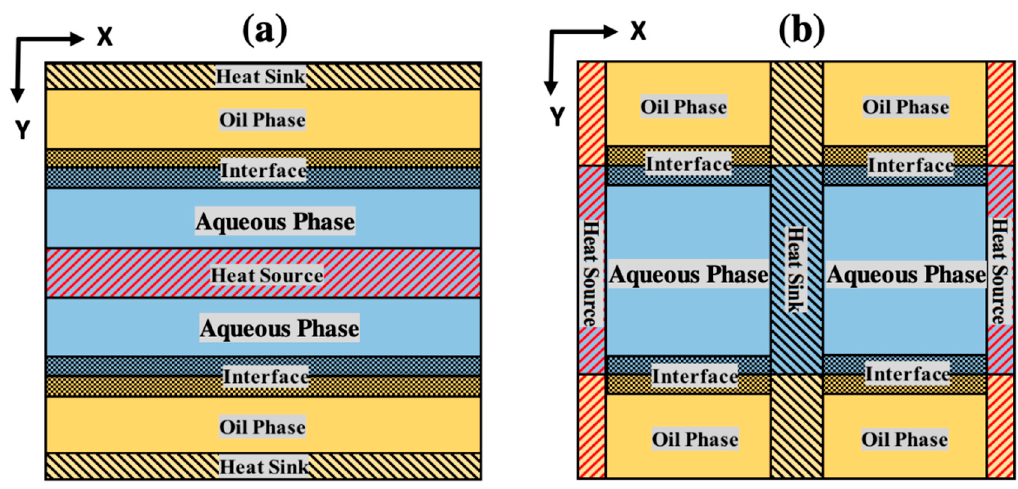
Figure 2. Schematic of systems composed of three phases to study the liquid-liquid interfacial thermal conductivity. The simulation box dimensions are 86.76 × 86.76 × 28.92 Å. Different areas are self-explained in the figure. System ( a ) is used to study the interface when the heat is transferred along the direction perpendicular to the interface. The interfaces are denoted as δ ⊥ in the text. System ( b ) is the parallel case, and the interfaces are denoted as δ ||.